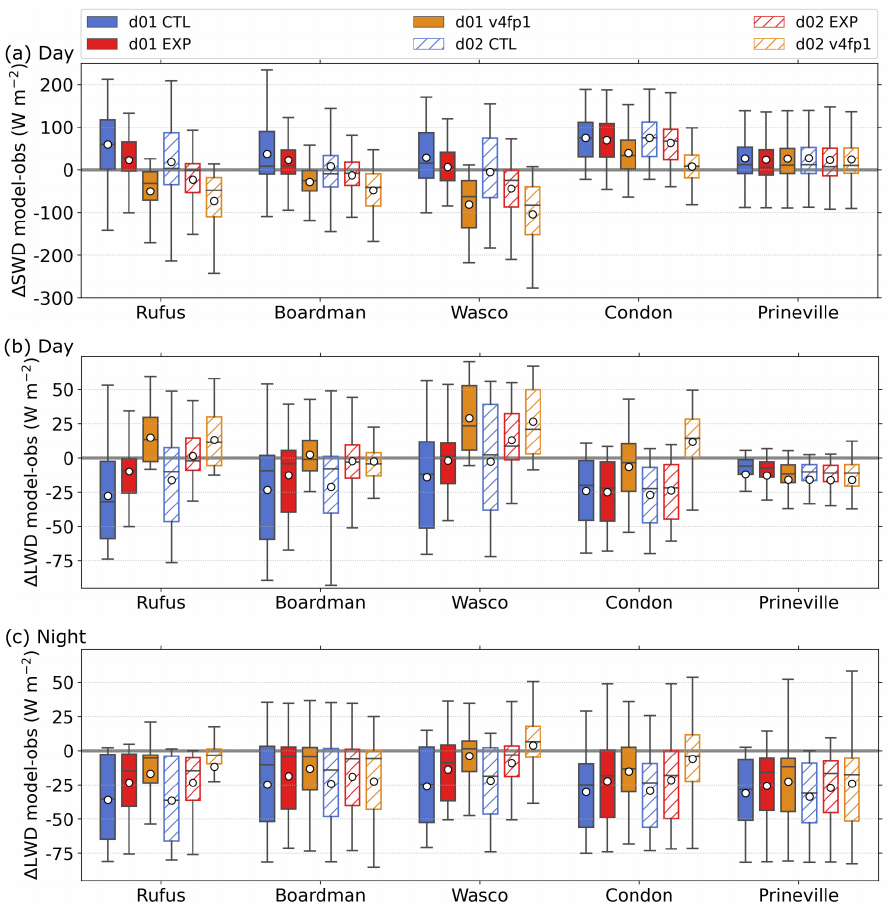
Figure 8. Box plot of (a) daytime surface shortwave downward radiation flux bias (cid:49) SWD as well as (b) daytime and (c) nighttime surface longwave downward radiation flux bias (cid:49) LWD between the different model runs (versions: CTL, EXP, v4fp1; domains: d01, d02) and the observations at Rufus, Boardman, Wasco, Condon, and Prineville during the CAP period. The white circles indicate the mean biases, boxes show the interquartile range with the median indicated by the horizontal line, and the whiskers extend to the points that lie within 1.5 times the interquartile range of the lower and upper